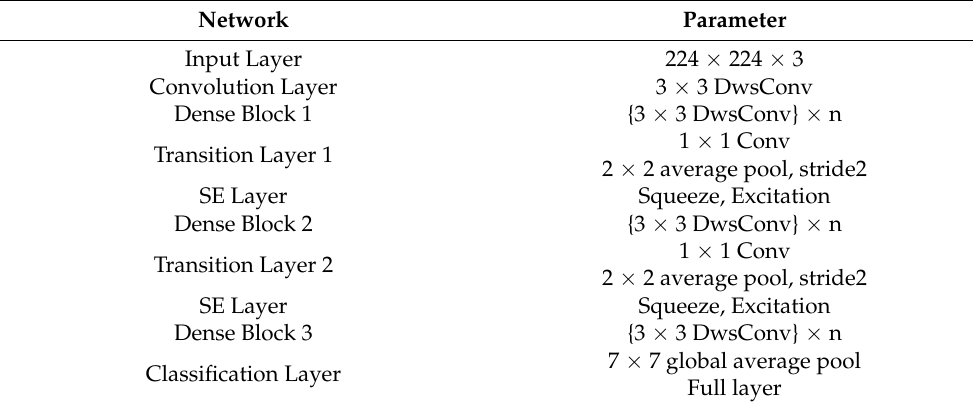
Table 1. SE-DenseNet model frame